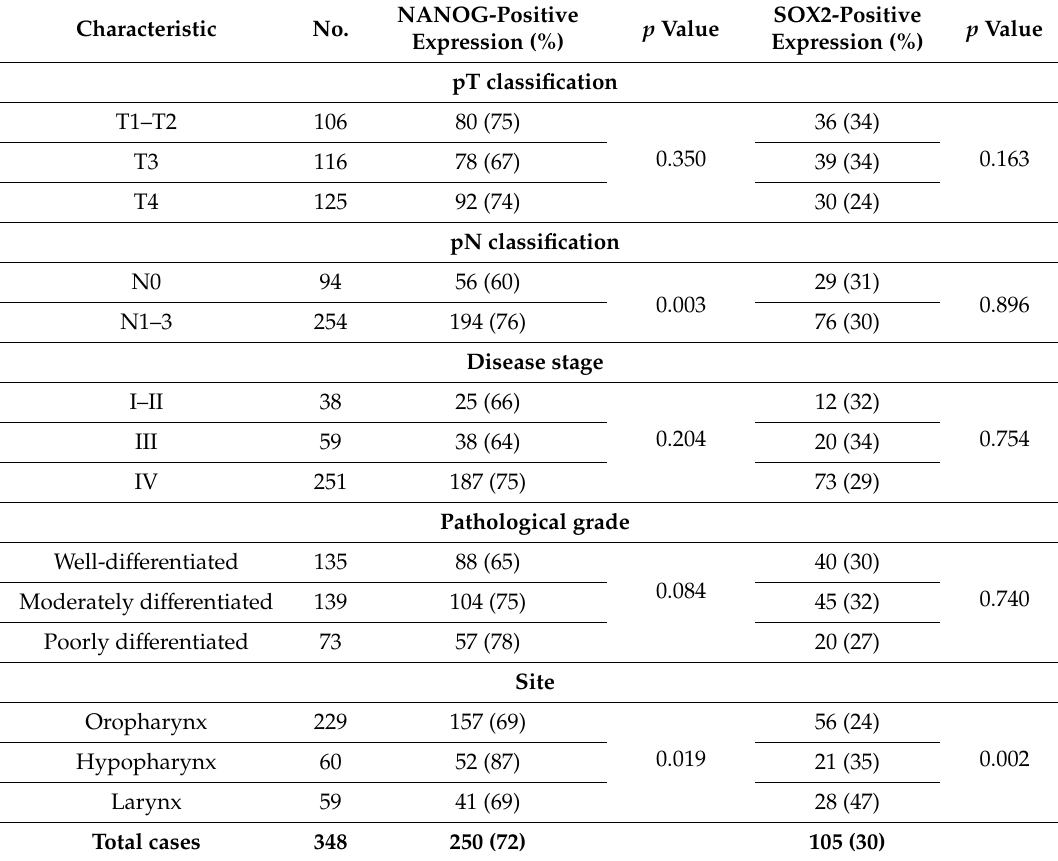
Table 1. Correlations between NANOG and SOX2 expression and clinicopathological